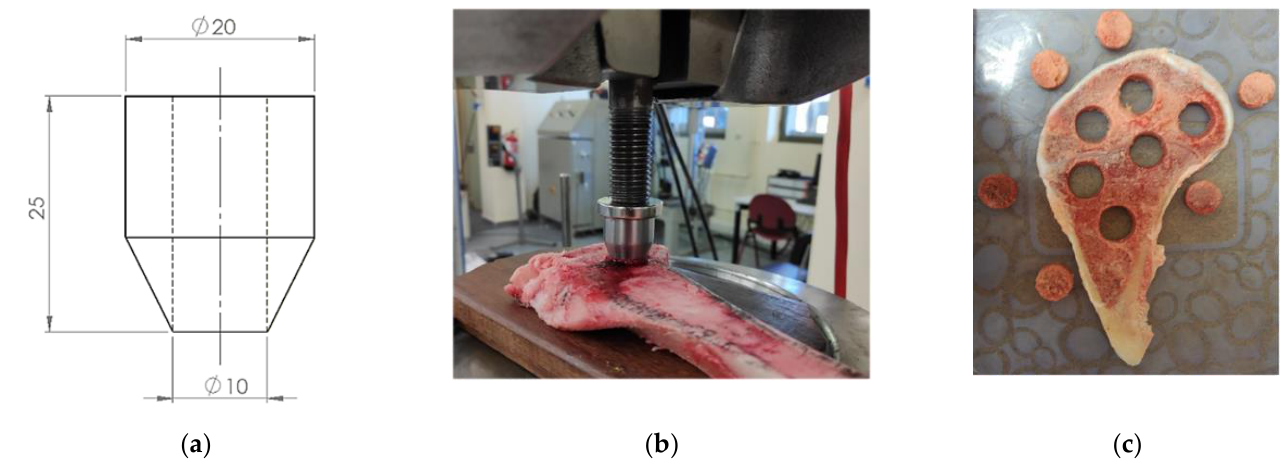
Figure 3. Extraction of the samples from the slices: ( a ) extraction tool (measurements in “mm”) ; ( b ) specimen extraction process; ( c ) extracted specimens from one slice.